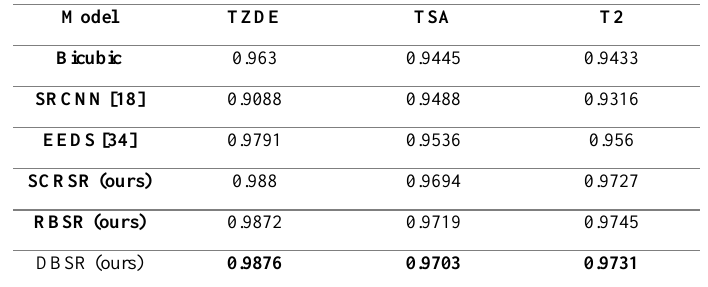
Table 2. Evaluation results on the T2 dataset using SSIM metric and scale factor 2.